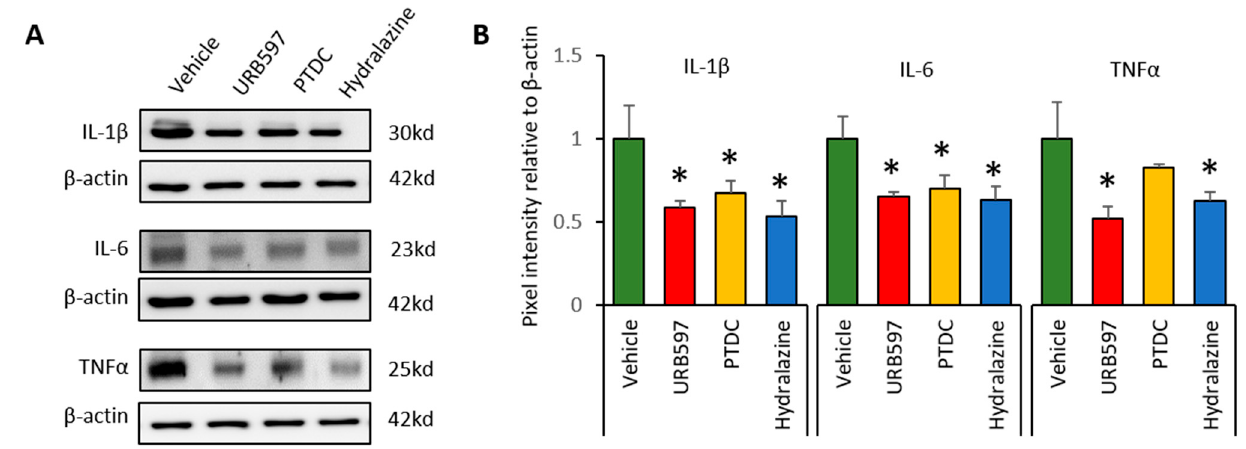
Figure 4. Changes in the relative density of IL-1 β , IL-6 and TNF α protein in the ipsilateral DRGs (L3, L4 and L5). ( A ) Representative data indicate Western blotting for IL-1 β , IL-6, and TNF α in DRGs. After repetitive injection of drugs, protein levels decreased. ( B ) Protein expression changes after drug application. n = 5 rats/group; one-way ANOVA followed by Tukey post hoc test was used for statistical analysis; data represent mean ± SEM; * p < 0.05.